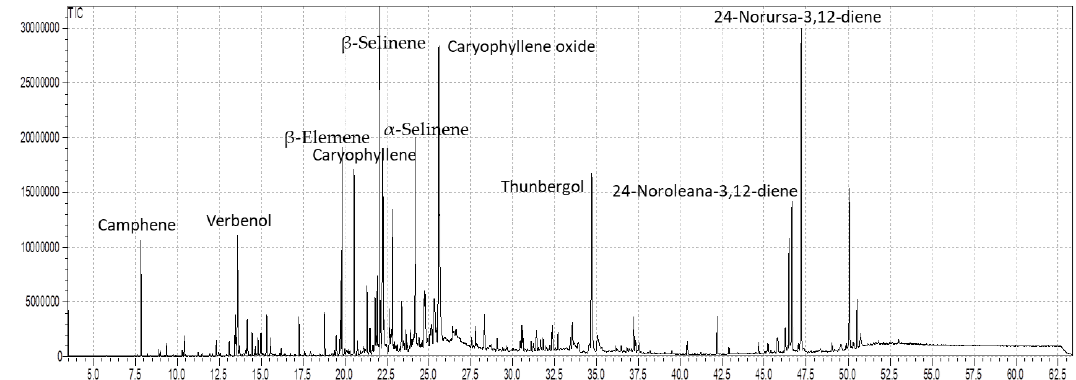
Figure 2. The GC chromatogram of the essential oils of the leaves of B. hirtum.